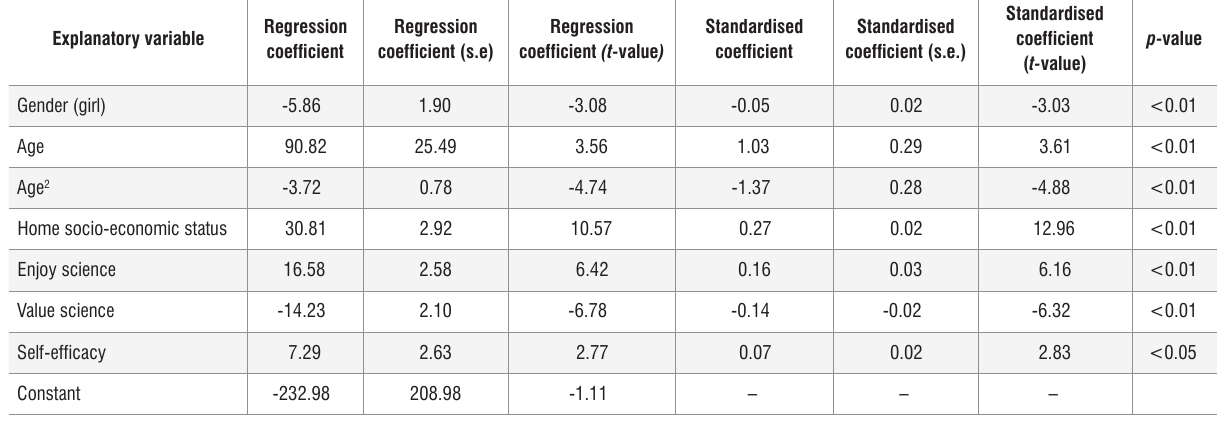
Multiple regression results investigating the association between science performance and self-efficacy Regression Regression Regression Standardised Explanatory variable coefficient coefficient (s.e) coefficient (t- value )